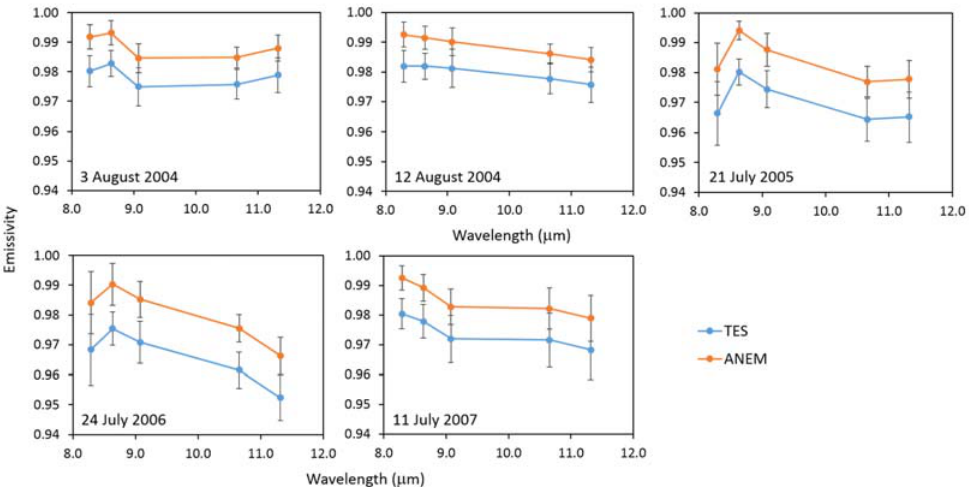
Figure 8. Mean emissivity retrieved with TES and ANEM methods using the pixels selected over orange fields for the five thermal ASTER bands.